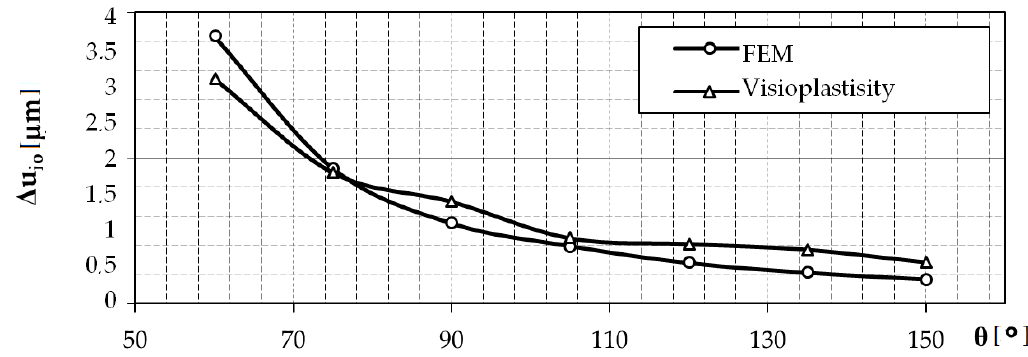
Figure 13. Influence of the vertical angle of surface asperities, θ , on the material elastic recovery ∆ u i0 .